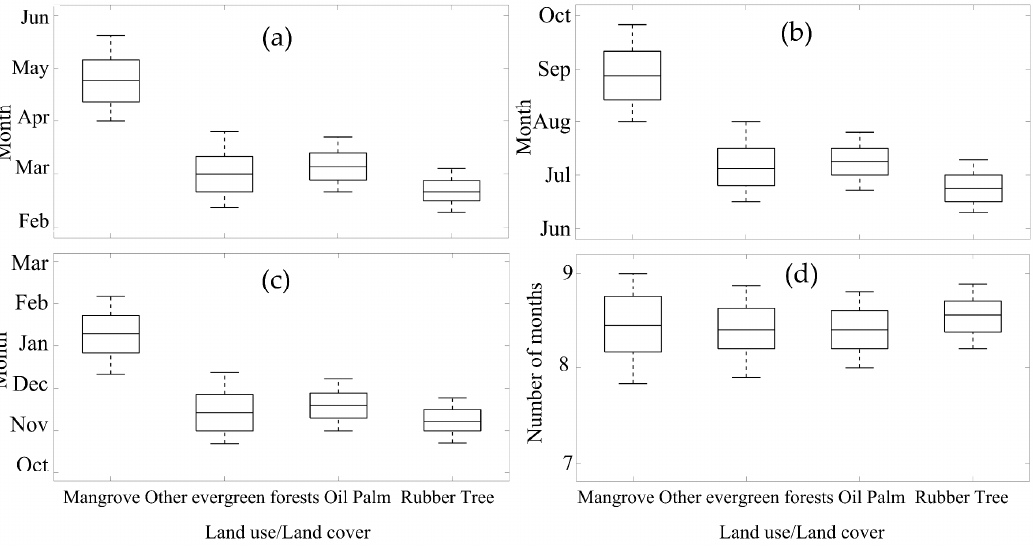
Figure 7. Boxplots of phenology parameters of the major land cover / land use type over Southern Thailand, ( a ) SOS, ( b ) POS, ( c ) EOS, and ( d )